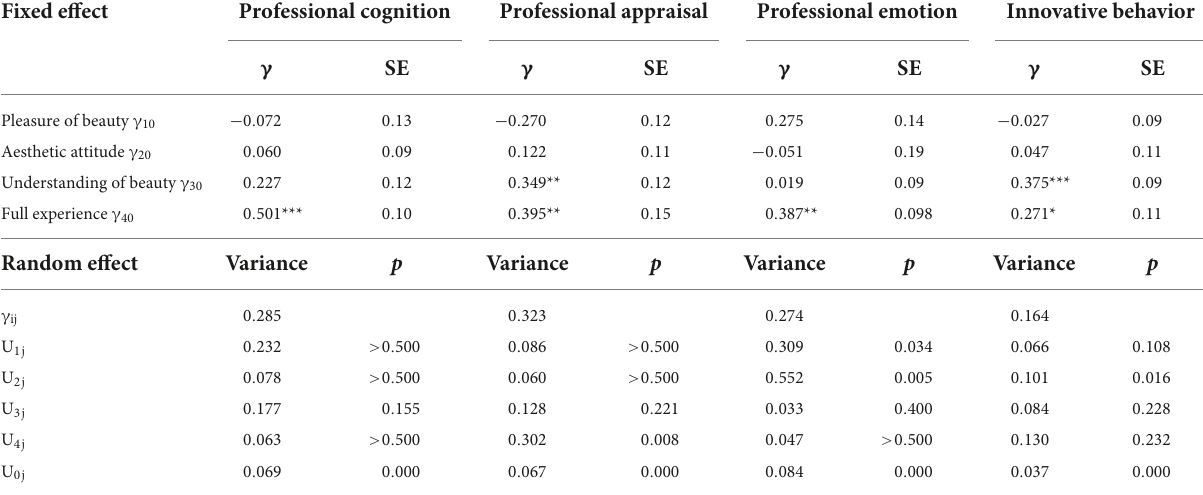
TABLE 1 Summary of random parameter regression